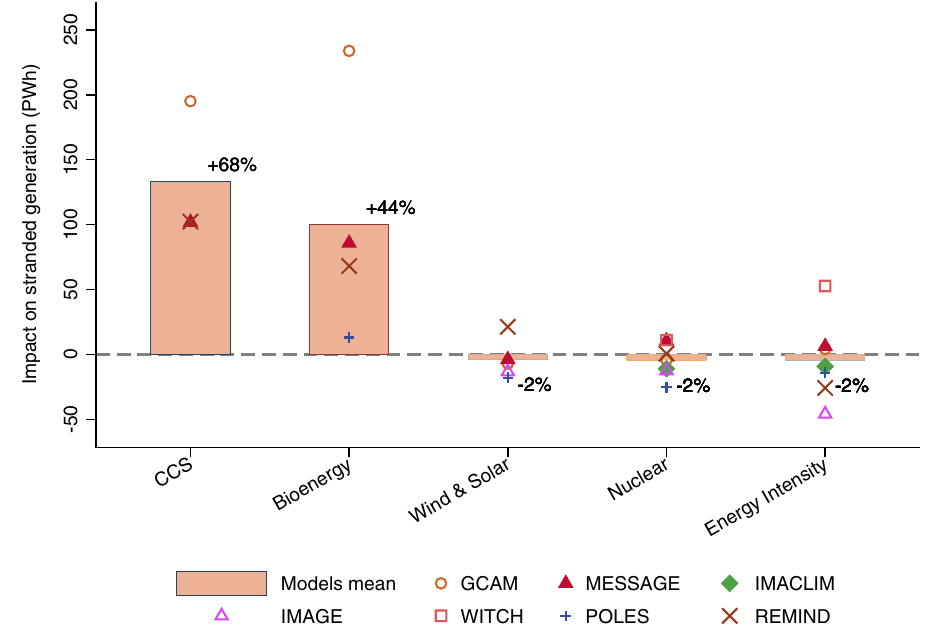
Fig. 4 Impact of technology availabilities on global stranded generation. Impacts are computed from the difference in stranded generation between all technologies deployed scenarios and the scenarios with one technology insuf fi ciently deployed. Positive effects suggest that the amount of stranded generation increases when a particular technology is unavailable or insuf fi ciently deployed. For energy intensity, the impact represented the difference between the scenarios where the energy intensity reduces at historical rates and 1.5 times historical rates. Scatter points represent the estimation of individual models and bars show the average across all integrated assessment models. The percentage values next to each bar represent the average change in stranded generation in scenarios with one technology insuf fi ciently deployed compared to the scenarios with all technologies